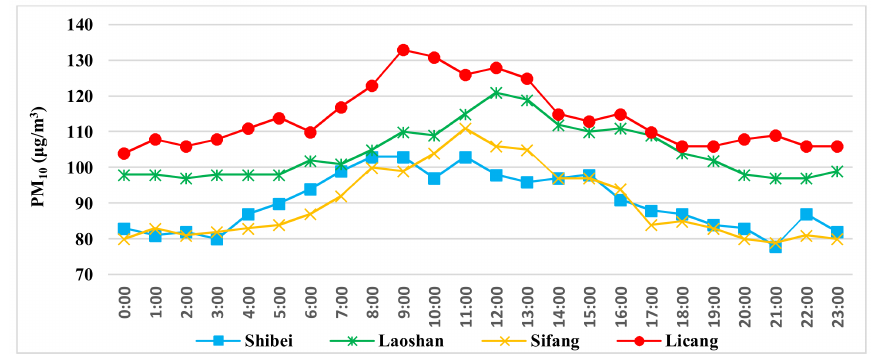
Figure 6. Chart of diel variation of concentration of PM 10 by hour in spring.